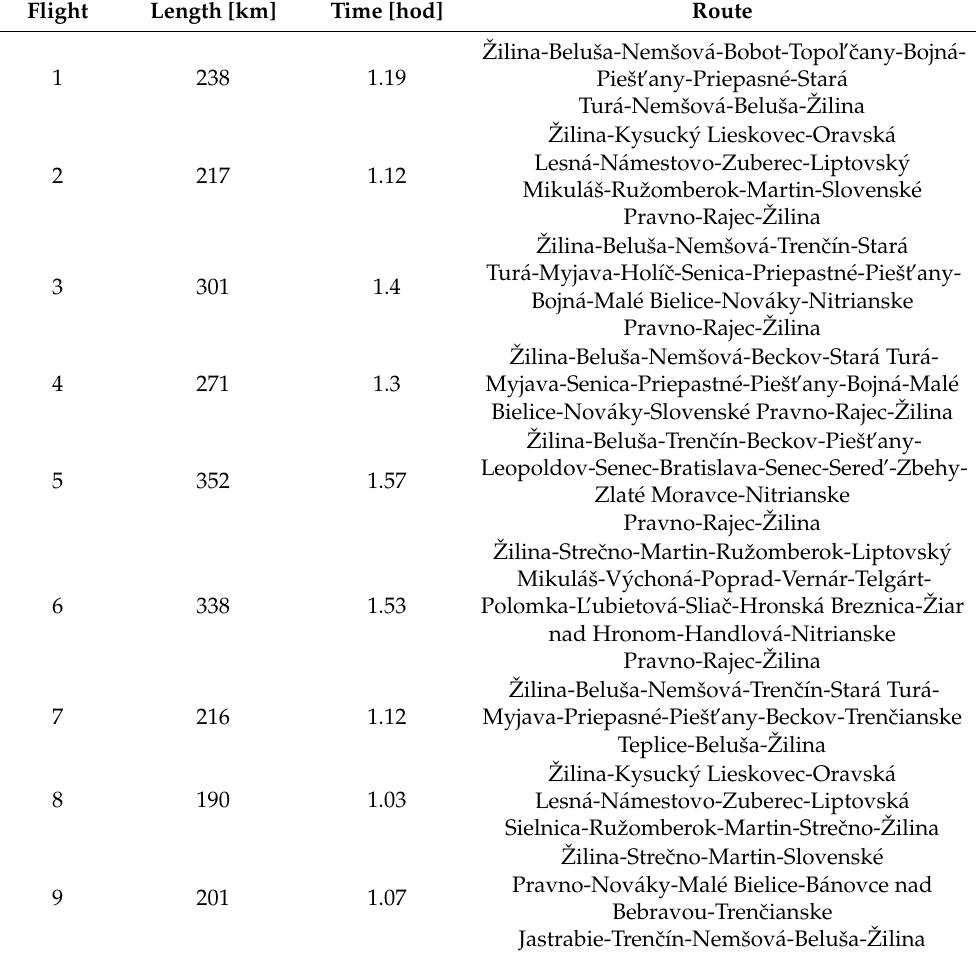
Table 4. Data on training flights used in serial hybrid system calculations. Source: Authors. Flight Length [km] Time [hod] Route 1 238 1.19 Piešt’any-Priepasn é -Star á